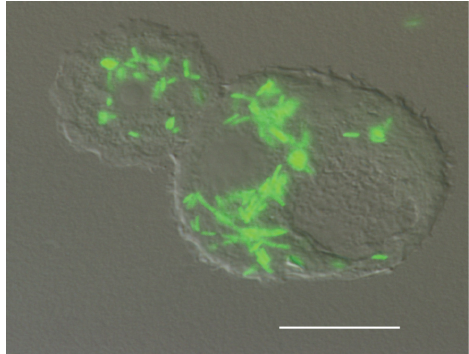
Figure 2. A. castellanii infected with L. pneumophila expressing green fluorescent protein. Scale bar represents 10 μ